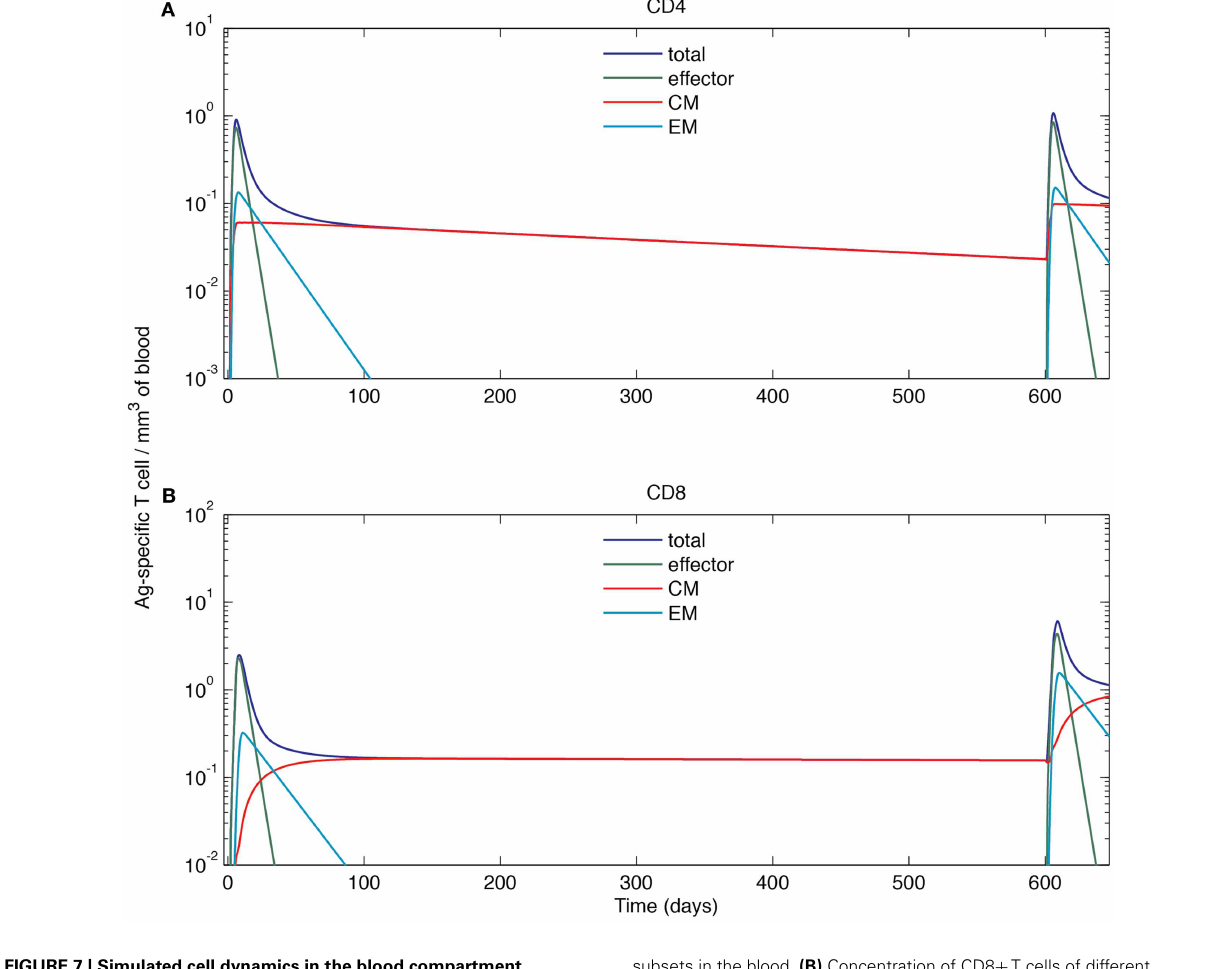
FIGURE 7 | Simulated cell dynamics in the blood compartment during a primary and recall response to a hypothetical acute infection (log scale) . (A) Concentration of CD4 + T cells of different